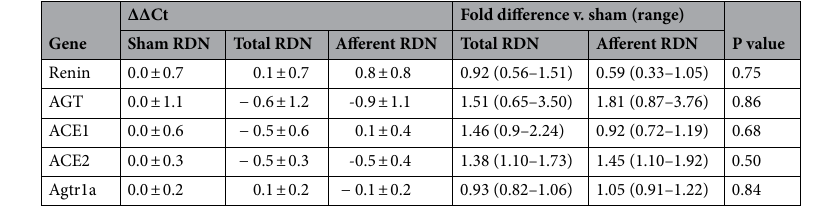
Table 2. Fold difference in kidney RAS gene expression in Lewis rats after RDN. RAS renin-angiotensin system, AGT angiotensinogen, ACE angiotensin-converting enzyme, Agtr1a angiotensin type 1a receptor. Data are presented as ΔΔCt with the sham animals used as the reference group. Fold difference (range) was calculated using the 2 −(ΔΔCt ± Standard Error (SE) of the ΔCt) method.